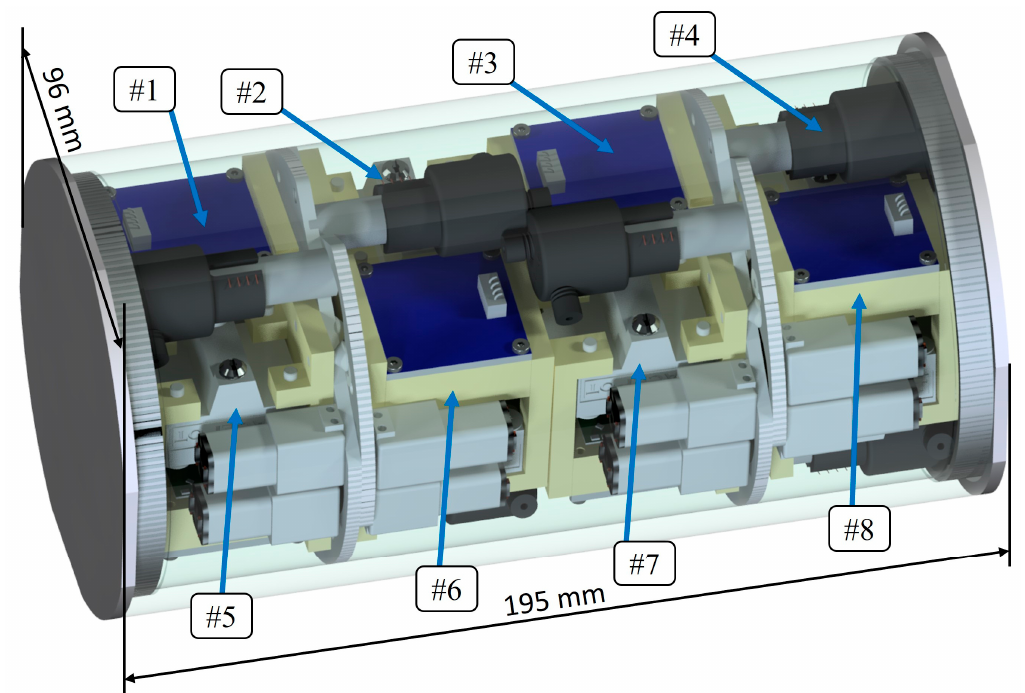
Figure 8. Payload concept containing 8 micropot experiments in a 2U nanosatellite. The numbers indicate the separate micropot experiment modules.